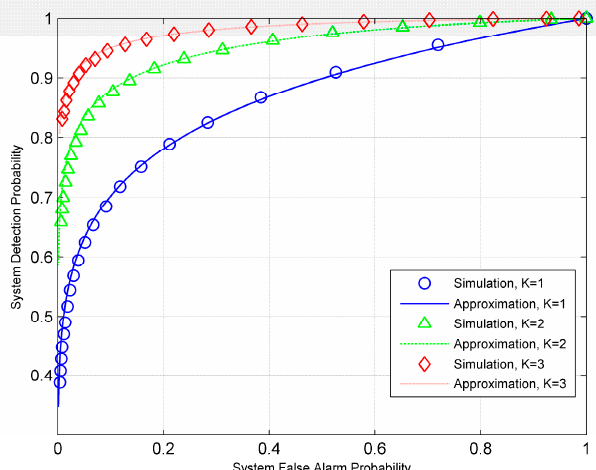
Figure 7. ROC curves for the ED fusion rule with L = 100.